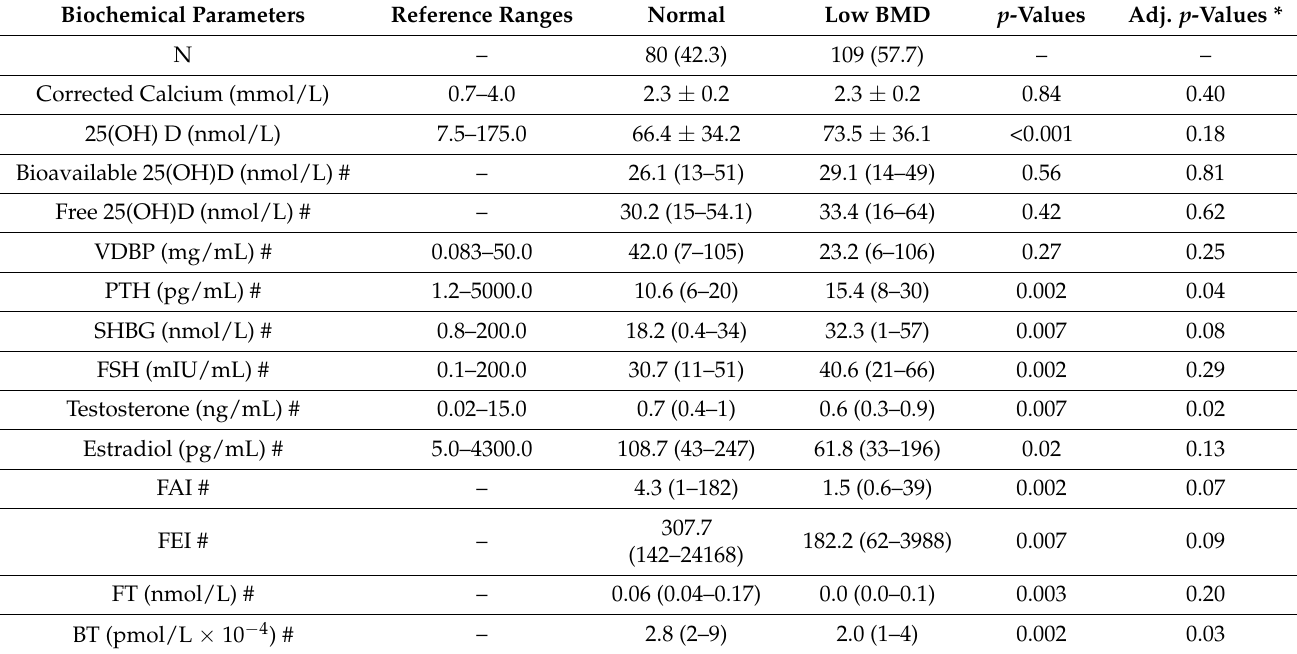
Table 2. Hormonal characteristics of participants according to Normal and Low BMD groups.